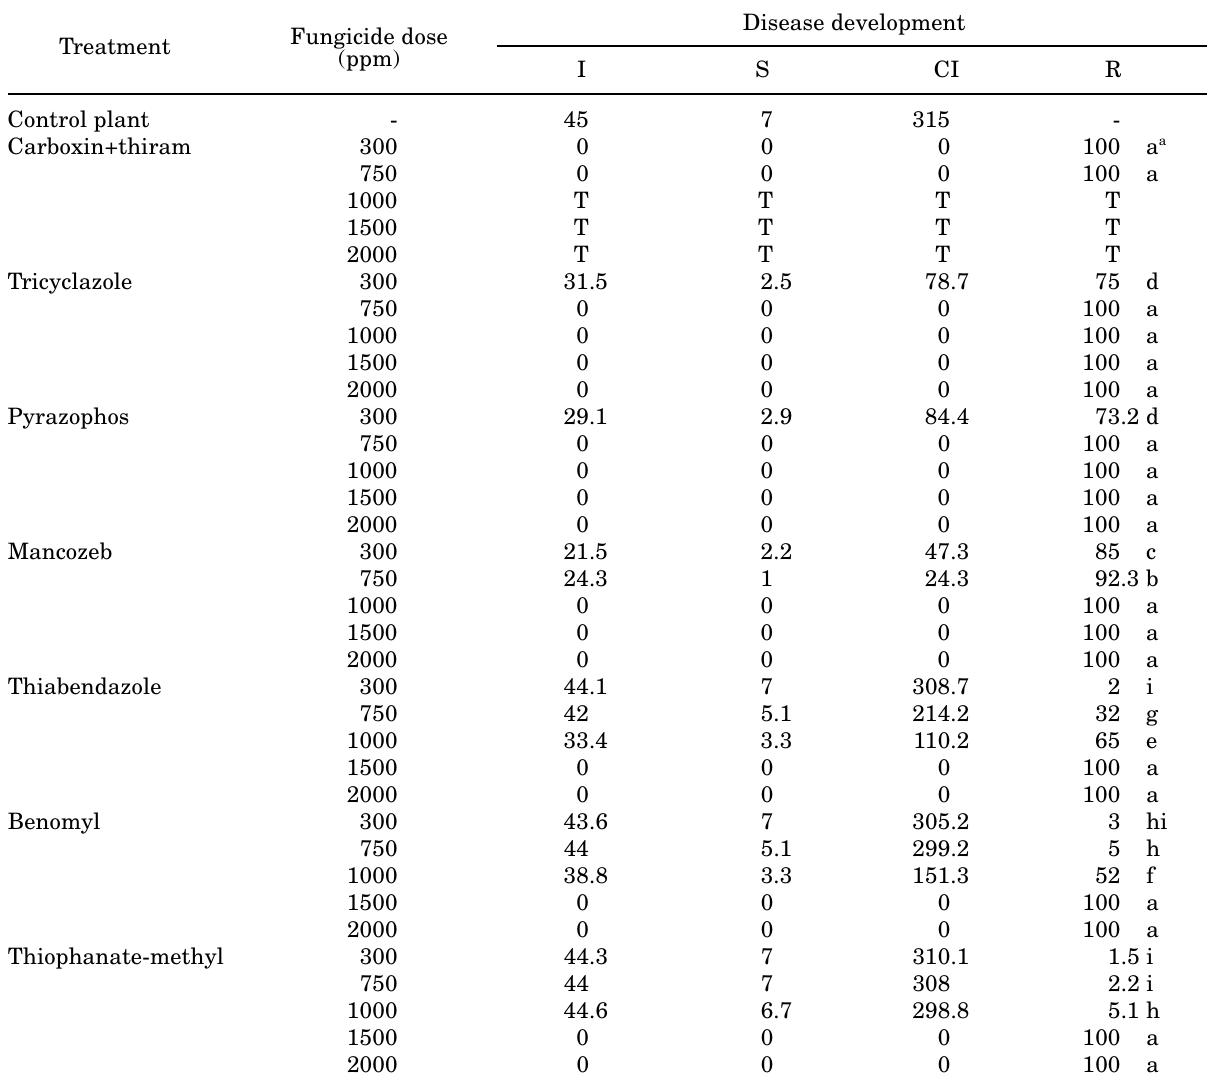
Table 6. Disease incidence (I), severity (S) and infection coefficient (CI) induced by Pyricularia grisea on young rice plants treated with various doses of fungicides and percent disease reduction